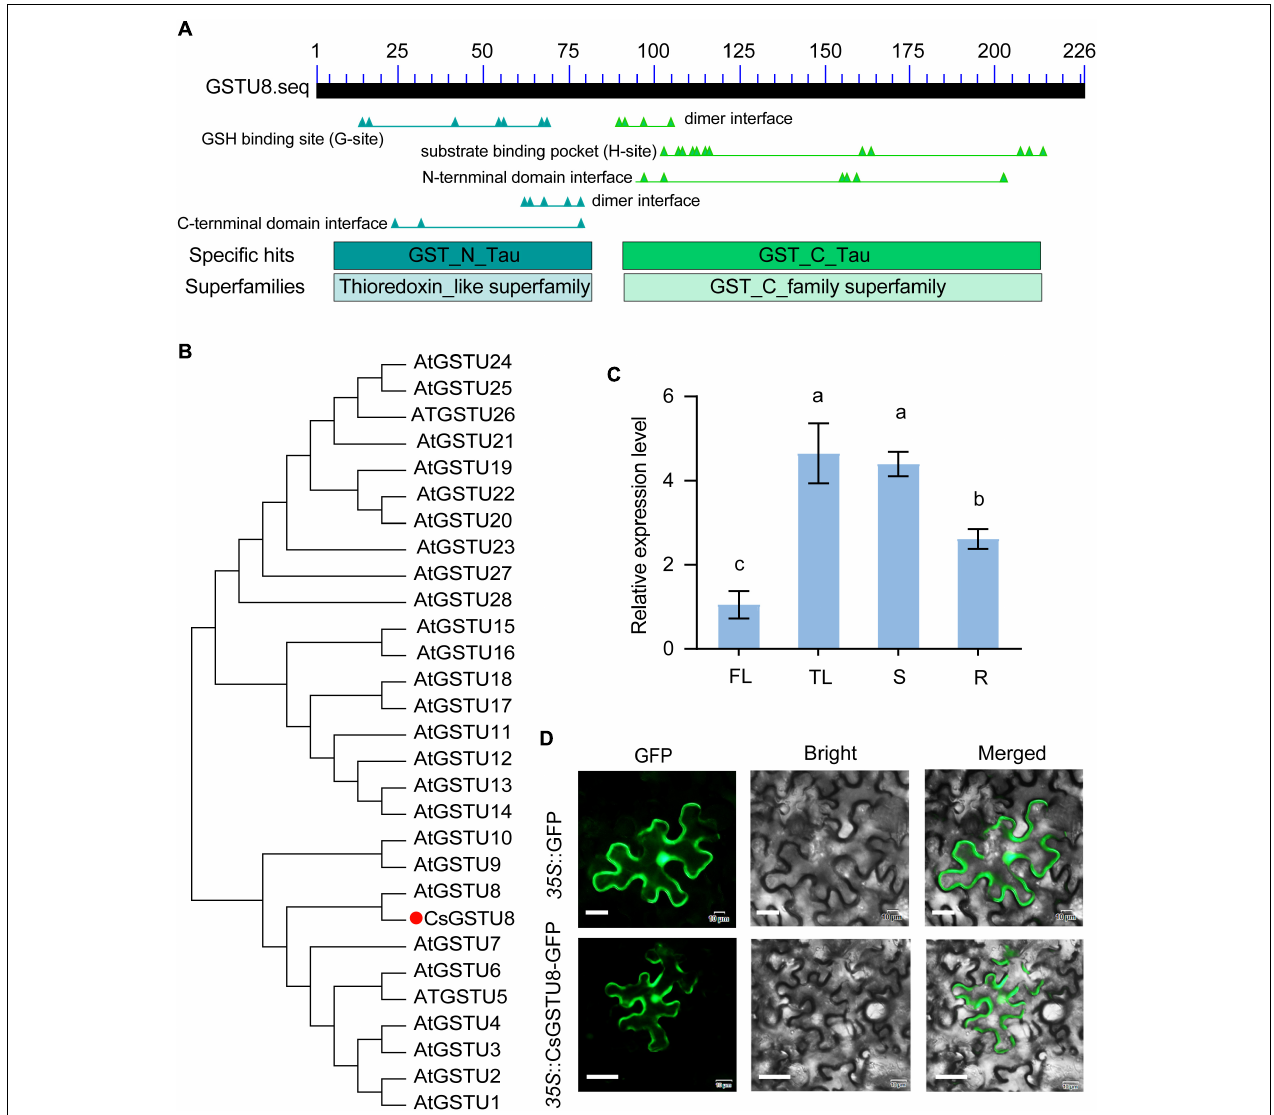
FIGURE 1 | Characterization of CsGSTU8 from Camellia sinensis . (A) Conserved domain analysis of the CsGSTU8 protein sequence retrieved from the NCBI database (https://www.ncbi.nlm.nih.gov/Structure/cdd/). (B) Phylogenetic analysis of CsGSTU8 and GSTU proteins from Arabidopsis . (C) Expression of CsGSTU8 in different tissues. FL (first leaf), TL (third leaf), S (stems), R (root tips). The data are the means ± SDs of three independent experiments. The values not followed by the same letter are significantly different according to Duncan’s multiple range test ( P < 0.05). (D) Subcellular localization of 35S::CsGSTU8-GFP and 35S::GFP in tobacco cells,. Bar = 20 µ